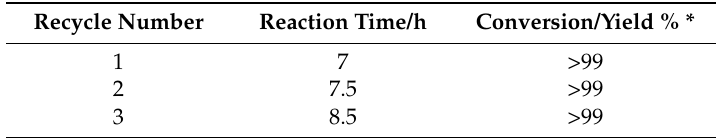
Table 3. Reaction time and percentage yield of the β -amino alcohols of cyclohexene with respect to the cycle number.